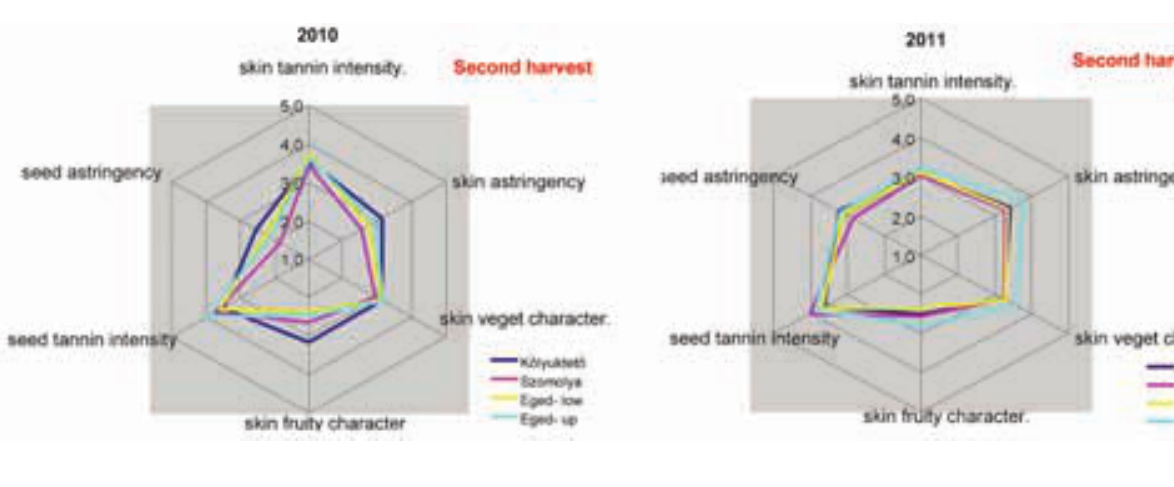
Figure 1 b: Main sensorial characters of the berry skin and the seeds (2010-2011- Second harvest time)